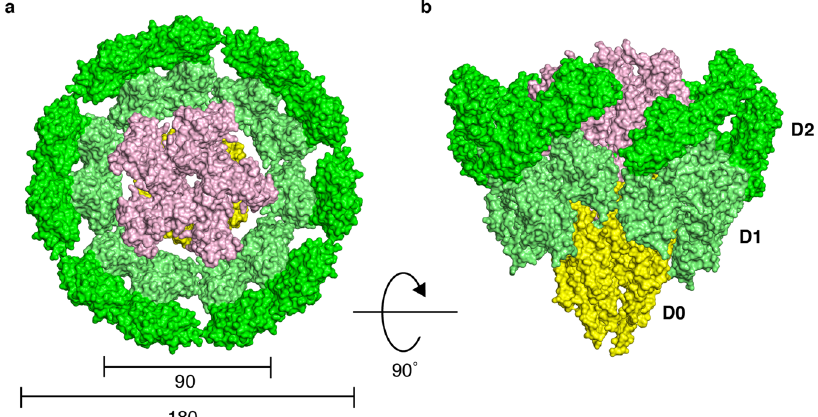
Fig. 4 A possible docking model of the hook cap on the hook. a , b The hook cap was fi tted into the growing tip of the hook (PDB-id: 3A69). The domains of FlgE (402 residues from S. enterica ) in the hook are labeled as D0 (1 – 24, 367 – 402), D1 (71 – 144 and 286 – 357), and D2 (145 – 285). The hook cap (light pink) and the hook (D0; yellow, D1; lime, D2; green) are shown in solid surface representation and viewed from the top ( a ) and side ( b ). The diameters of the hook cap and the hook are 90 Å and 180 Å, respectively. For clarity, only 11 molecules of FlgE are displayed for the hook.